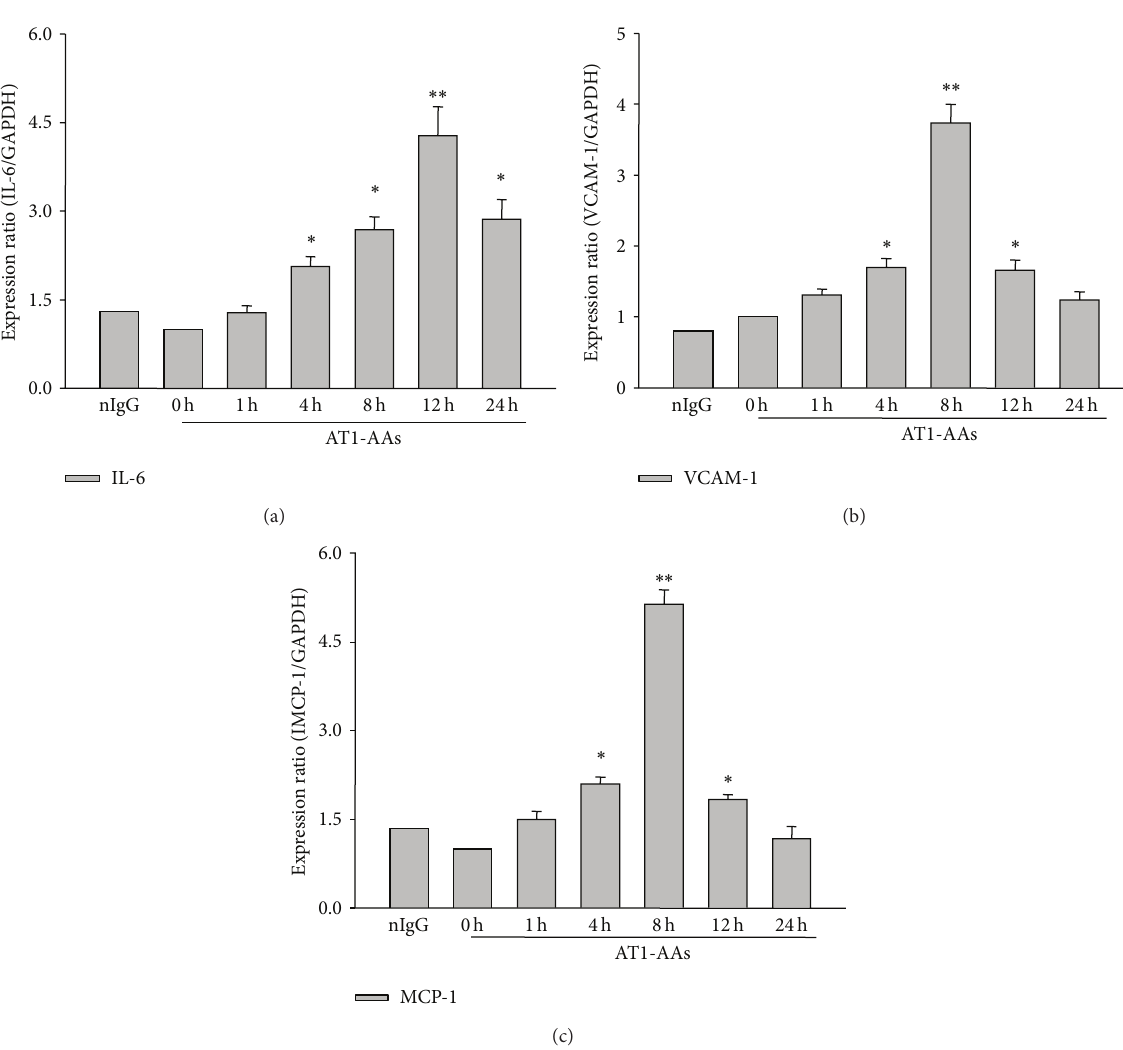
Figure 3: IL-6, VCAM-1, and MCP-1 mRNA expression in human endothelial cells stimulated by AT1-AAs. In cells incubated with AT1-AAs (20 𝜇 g/mL) for 0, 1, 4, 8, 12, and 24 hours or human nonspecific IgG (20 𝜇 g/mL) from the patients for 8 hours as a negative control, the IL-6 (panel (a)), VCAM-1 (panel (b)), and MCP-1 (panel (c)) mRNA levels were detected by real-time quantitative PCR analysis. 𝑦 -axis represents the relative mRNA levels; ∗∗ 𝑃 < 0.01 ; ∗ 𝑃 < 0.05 versus 0 hour (control); 𝑁 = 6 . (nonspecific IgG group 𝑛 = 1